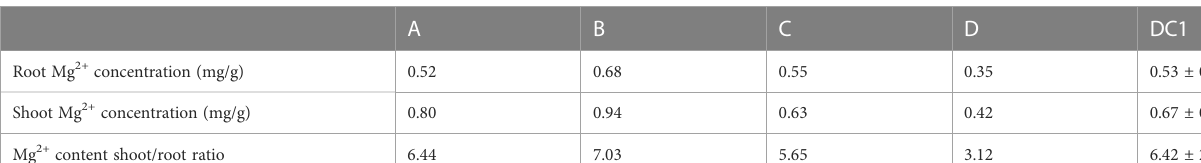
TABLE 1 Root and shoot Mg 2+ concentration of the parental lines and DC1 population.